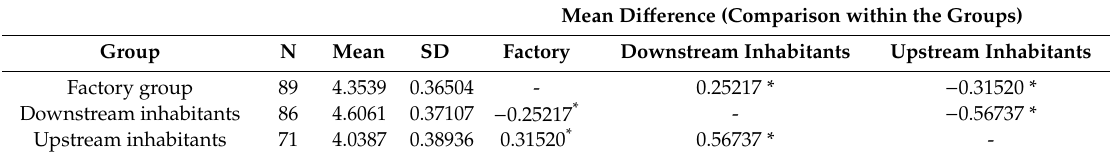
Table 4. Results of Tukey’s post-hoc analysis showing di ff erences in risk perception amongst the